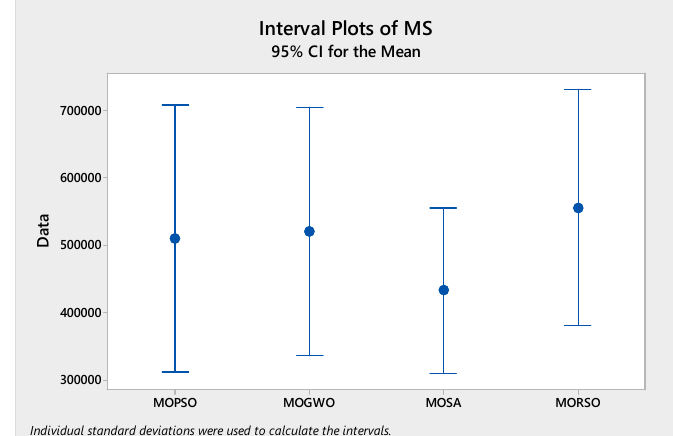
Figure 21. Interval plots of MS.